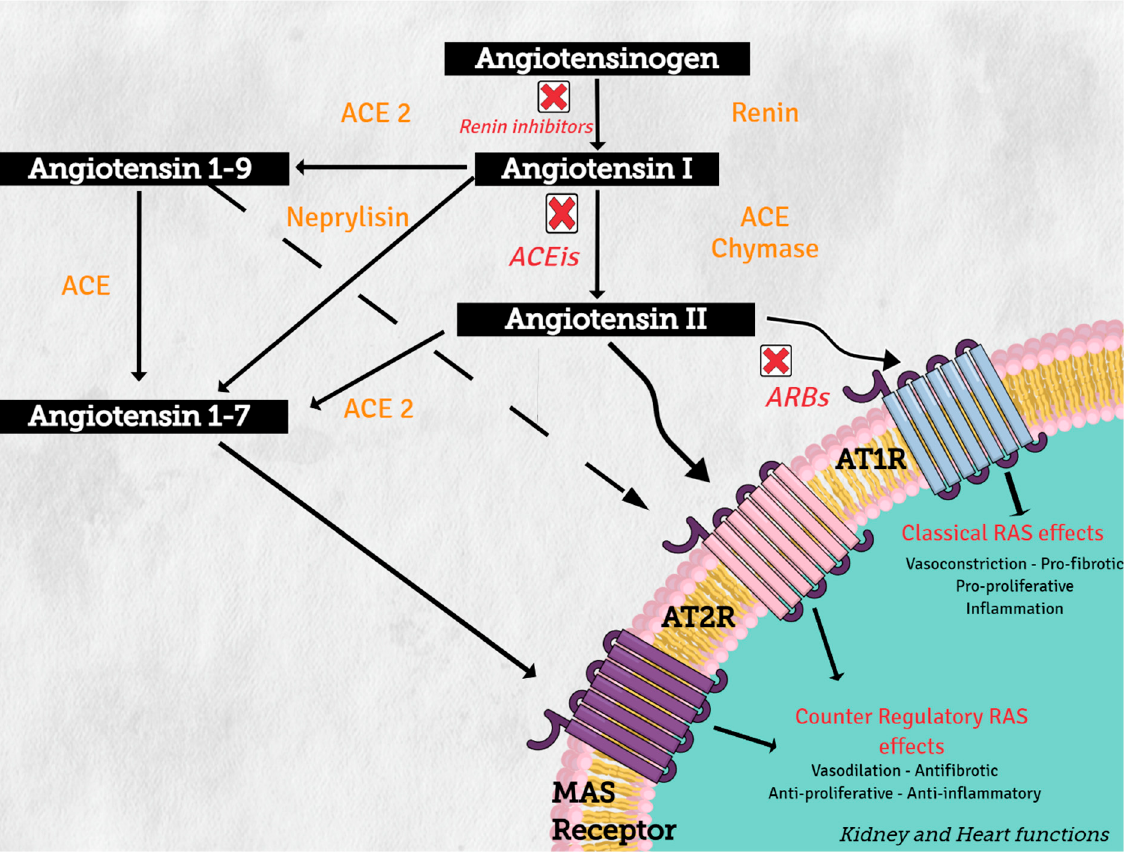
Figure 2. Renin–angiotensin system: classical and counter regulatory pathways. Abbreviations: ACE: angiotensin converting enzyme; ACE 2: angiotensin-converting enzyme type 2, ACEIs: angiotensin-converting enzyme inhibitors; ARBs: angiotensin-2 receptor 1 blockers, AT1R: angiotensin II receptor type1, AT2R: angiotensin II receptor type 2.